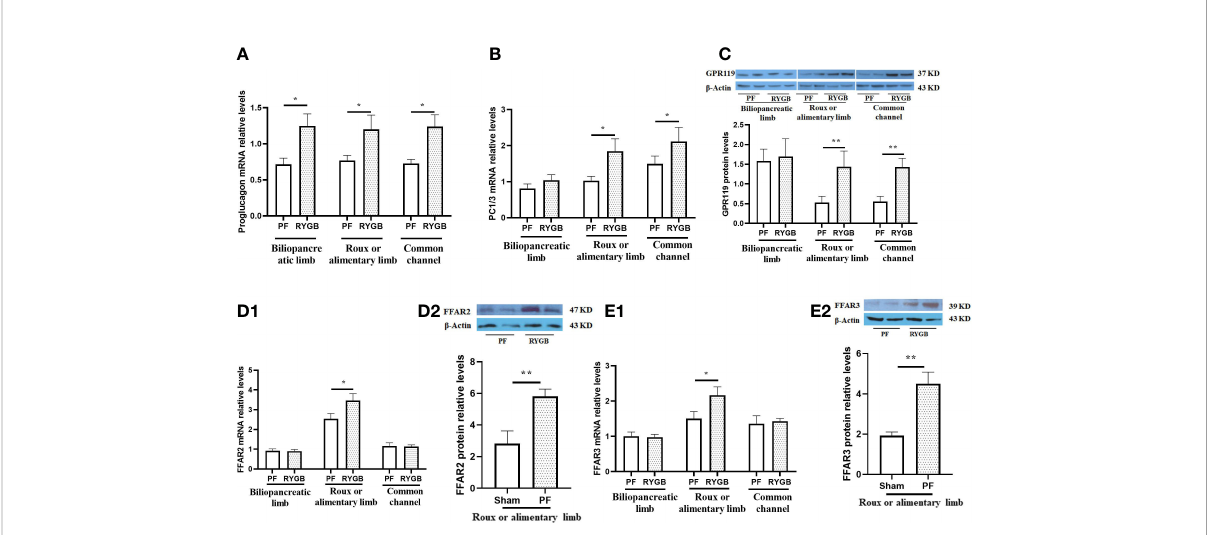
FIGURE 3 Effect of RYGB on the regulation of intestinal proglucagon and PC1/3 mRNA levels, protein levels of GPR119 and protein/mRNA of FFAR2/FFAR3. On POD 21, segments from the biliopancreatic limb (BP), Roux limb and common channel (CC) were harvested from RYGB rats along with corresponding segments from PF rats. Mucosal proglucagon (A) , PC1/3 (B) , FFAR2 (D 1 ) and FFAR3 (E 1 ) mRNA levels were measured by RT PCR. Mucosal GPR119 (C) , FFAR2 (D 2 ) and FFAR3 (E 2 ) protein levels were measured by Western Blot. Data are mean, ± SE, n=5-13 per group, *p<0.05,